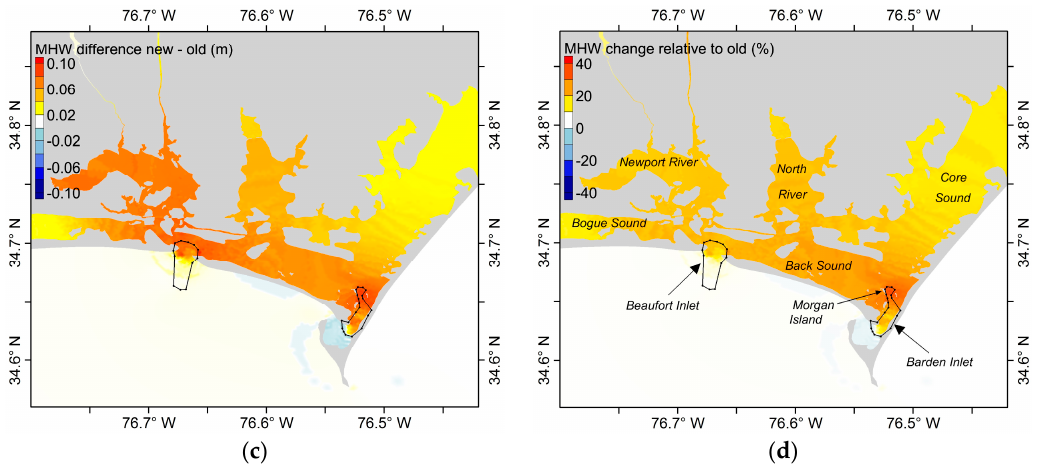
Figure 12. The MHW changes induced by the inlet morphological changes around Beaufort Inlet and Barden Inlet: ( a ) MHW from the old-bathy model; ( b ) MHW from the new-bathy model; ( c ) the MHW difference between the new-bathy model and the old-bathy model; ( d ) the MHW change in percentage relative to the old-bathy model MHW. The black dotted polygons delineate the area with changed bathymetry.